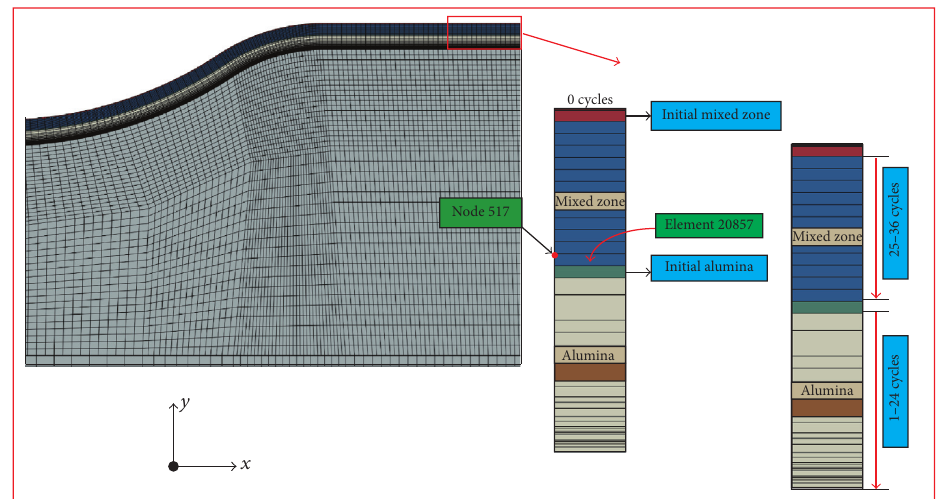
Figure 3: TGO thickening simulated by USDFLD in